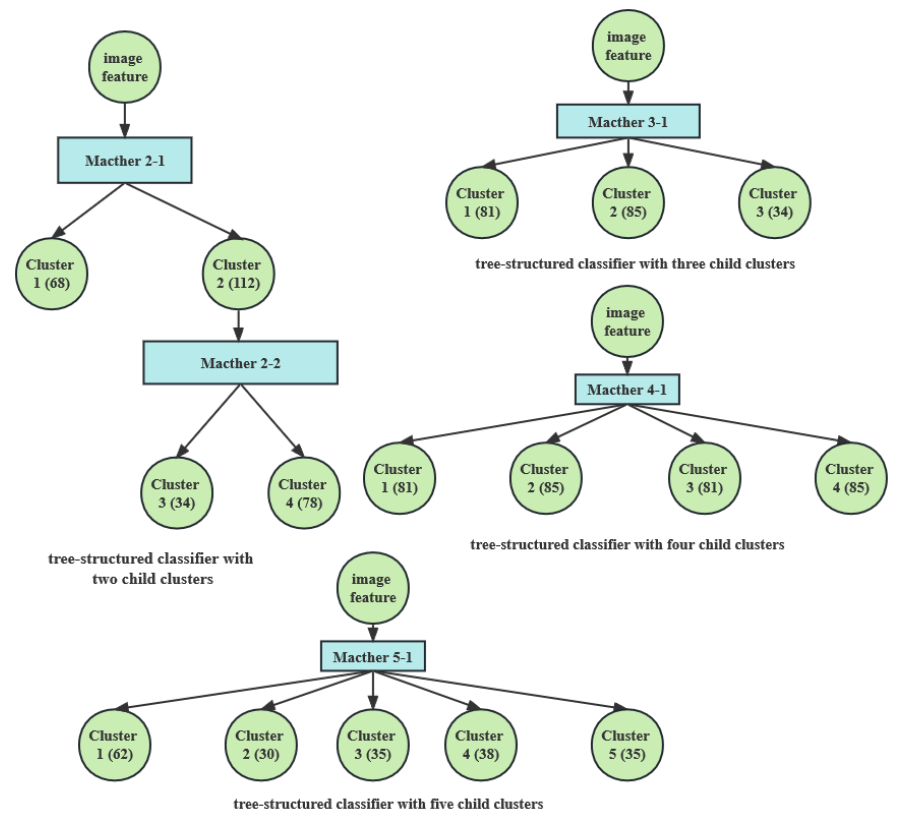
Figure 11. Structures of the proposed classifier and tested matchers. Table 6. Performance of tested matchers varies with different machine-learning